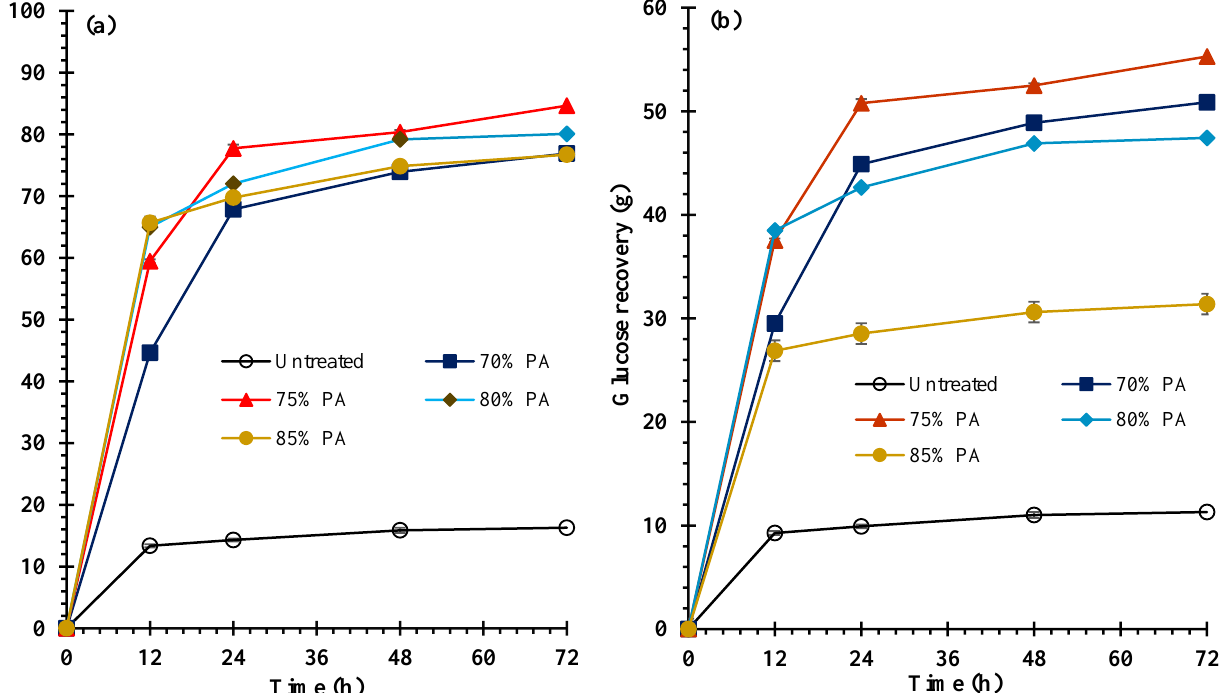
Figure 2. ( a ) Hydrolysis efficiency (HE) and ( b ) Glucose recovery (GR) of bark fiber.